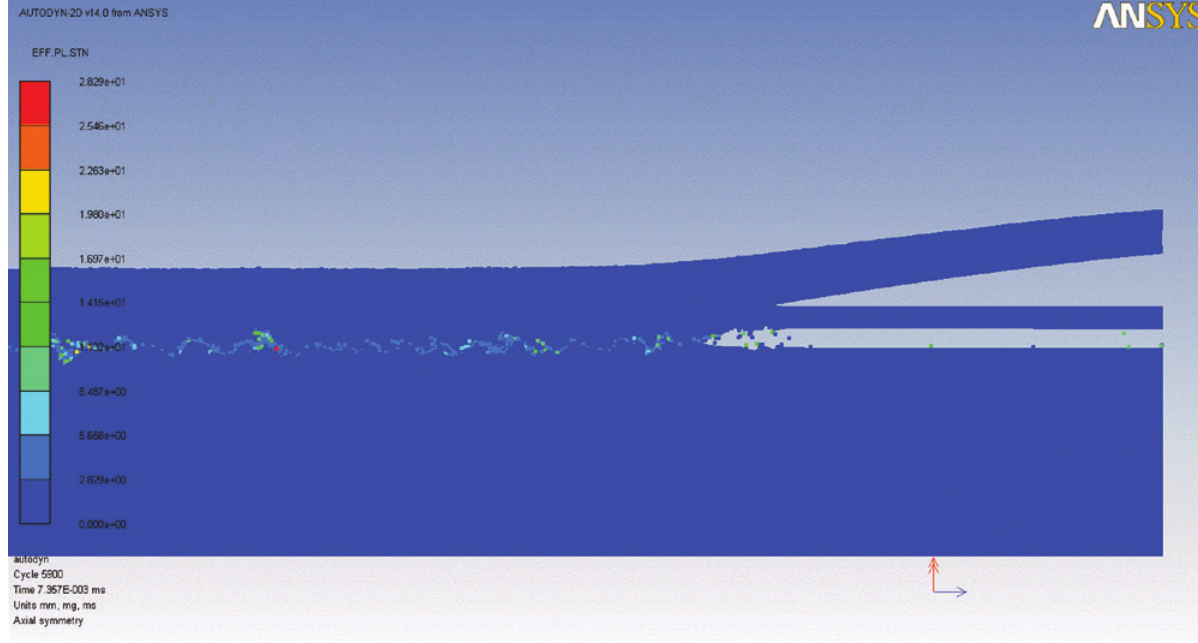
Figure 6: The effective plastic strain distribution of combination in the simulation.